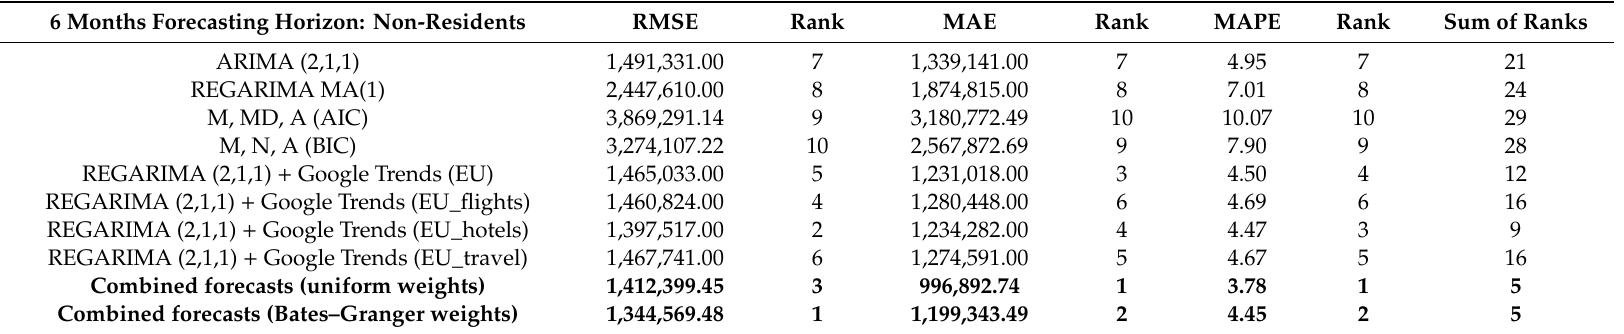
Table A2. Forecasting accuracy (December 2017): arrivals, non-residents, six months ahead. Source: European Commission (2017) and own calculations. Boldface indicates the single forecasting model(s) / forecast combination technique(s) characterized by the lowest sum of ranks. 6 Months Forecasting Horizon: